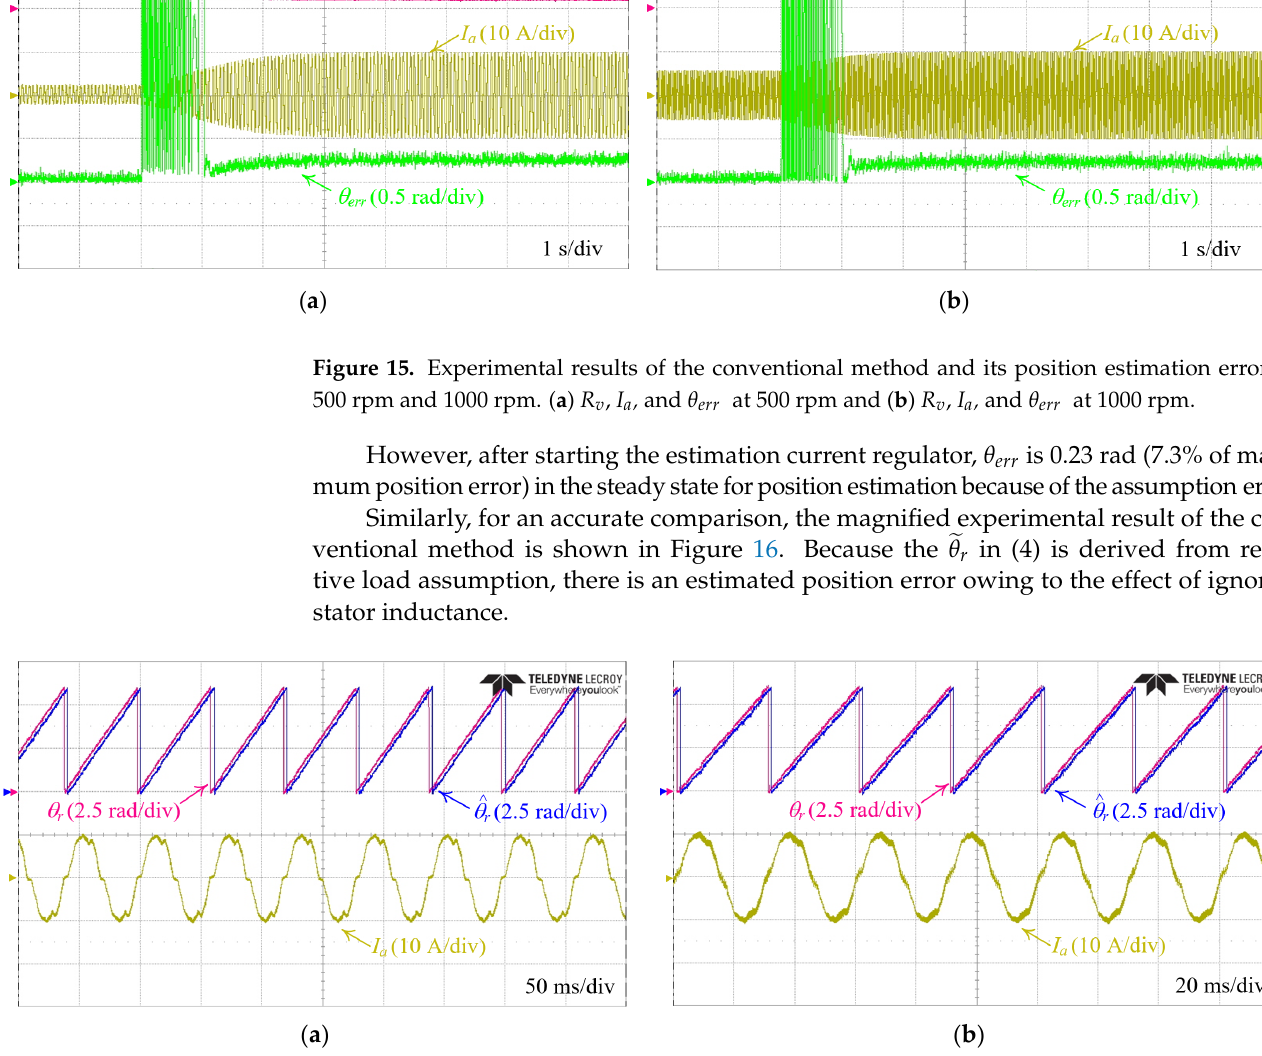
Figure 16. Magnified experimental results of the conventional method with actual position and estimated position at 500 rpm and 1000 rpm. ( a ) θ r , ˆ θ r , and I a 500 rpm and ( b ) θ r , ˆ θ r , and I a at 1000